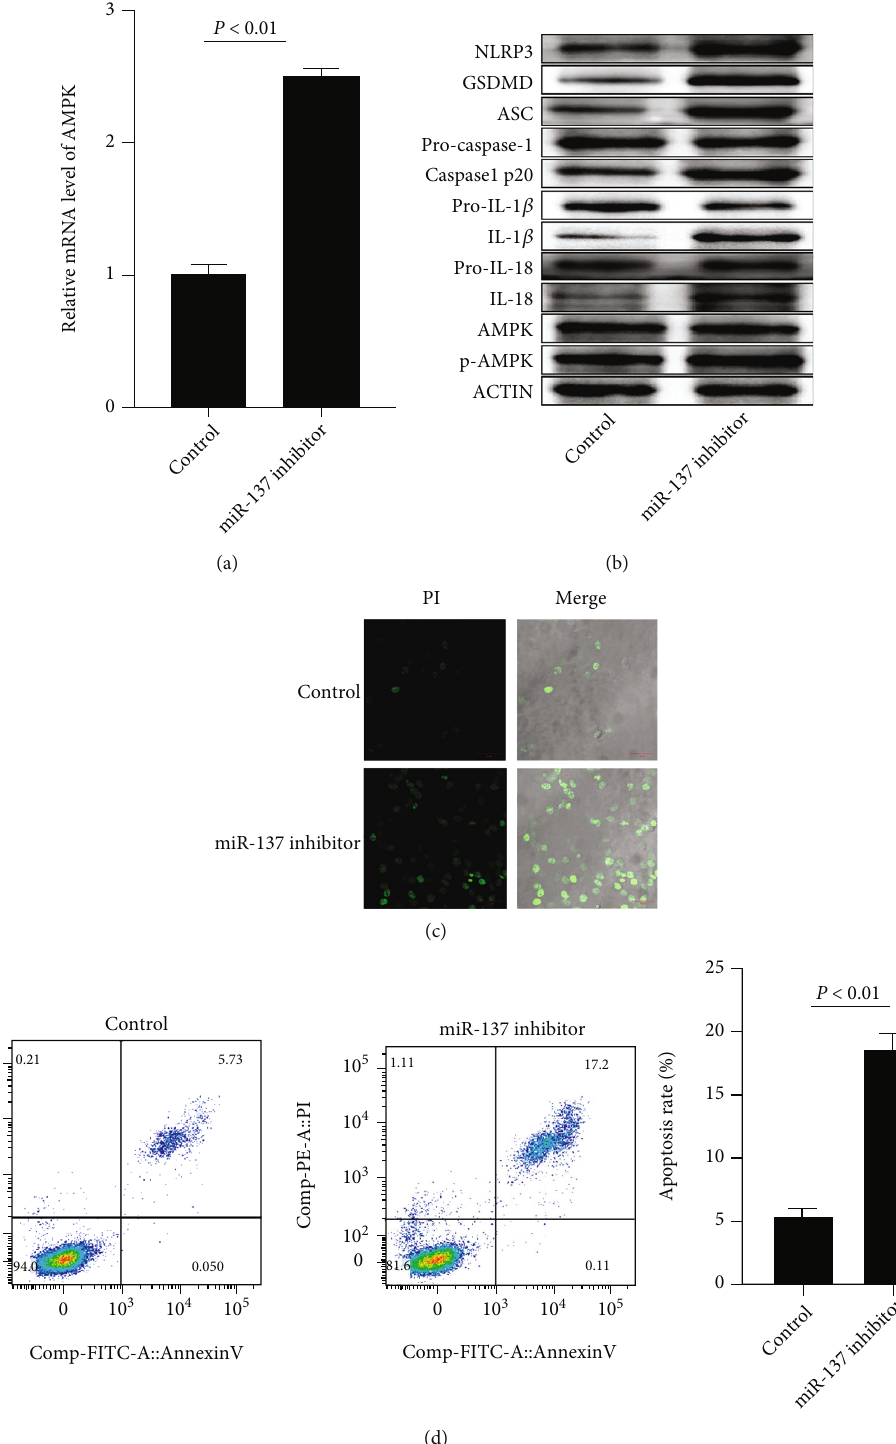
Figure 4: miR-137 inhibitor induces normal CD4+ T cell pyroptosis via mediating AMPK. (a) AMPK mRNA expression in normal CD4+ T cells after miR-137 inhibitor transfection. (b) Impact of miR-137 inhibitor transfection on in fl ammation and pyroptosis-related proteins in normal CD4+ T cells. (c) Impact of miR-137 inhibitor transfection on normal CD4+ T cell pyroptosis. (d) Impact of miR-137 inhibitor transfection on normal CD4+ T cell apoptosis. Each test ran in triplicates. The means were pairwisely compared using Student ’ s t -test. P < 0 : 01 means the presence of statistical signi fi